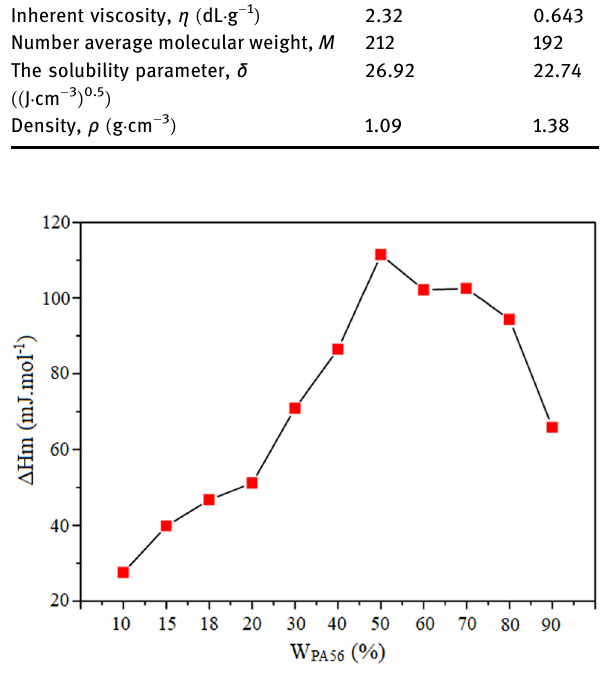
Figure 4: The calculated value Δ H m ( 10 − 3 J · mol − 1 ) of thermodynamic compatibility parameter of bio - based PA56/PET blend.